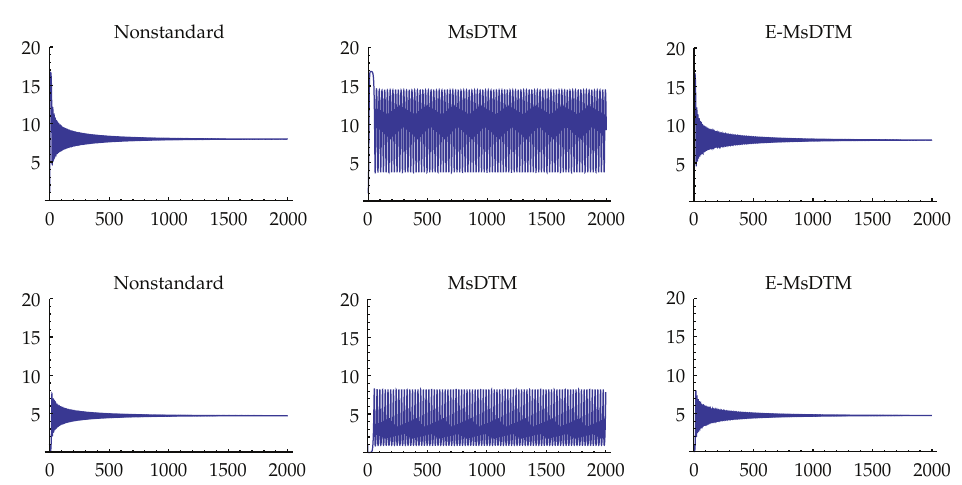
Figure 8: x (cid:4) t (cid:5) (cid:4) Top (cid:5) and y (cid:4) t (cid:5) (cid:4) Bottom (cid:5) ; nonstandard scheme (cid:4) Left, h (cid:8) 0 . 01 (cid:5) , MsDTM (cid:4) Middle, h (cid:8) 0 . 25 (cid:5) , E-MsDTM (cid:4) Right, h (cid:8) 0 . 25 (cid:5) ; k (cid:8) 16 .